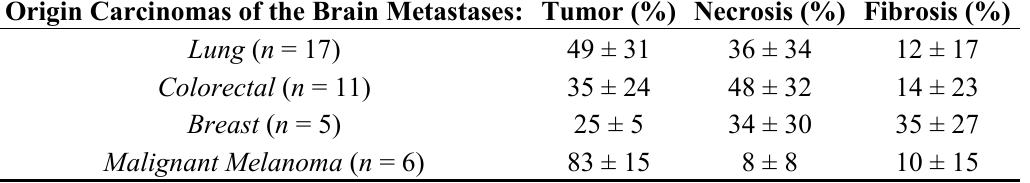
Table 2. Origin and mean percentages (± SD) of tumor, necrotic and fibrotic tissue of the brain metastases samples ( n = 39), described by HES-staining after high resolution magic angle spinning (HR-MAS)